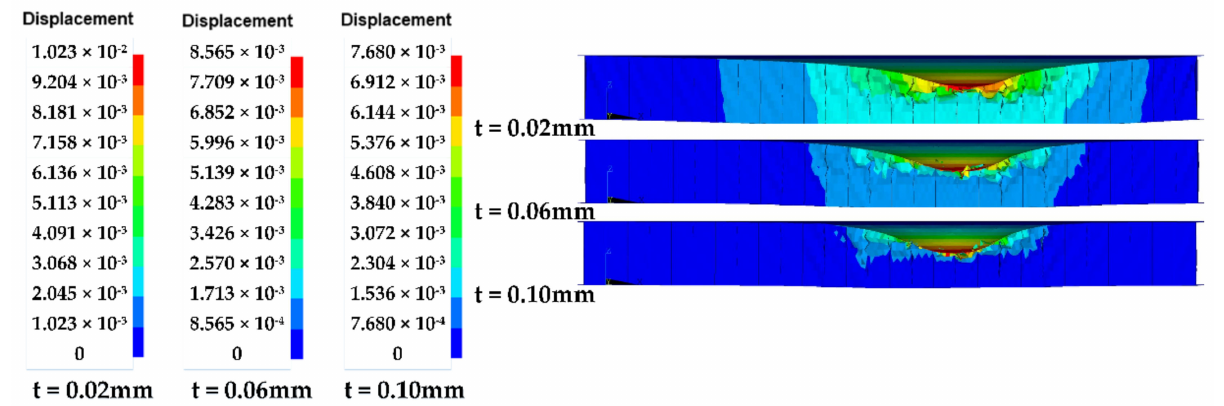
Figure 5. The cross-section view of the hexagonal honeycomb